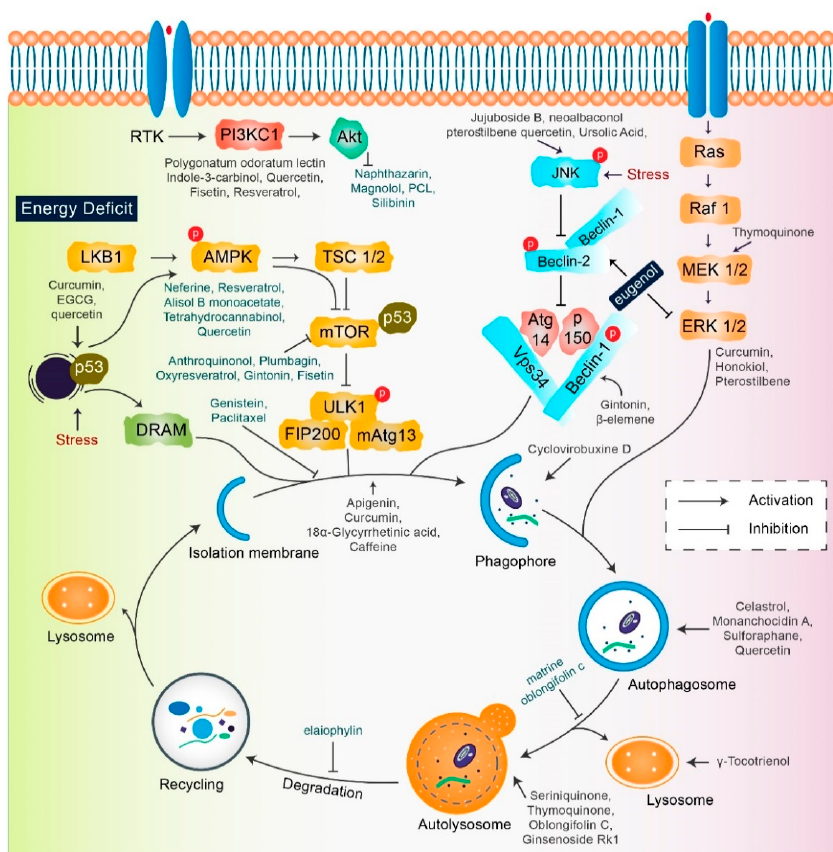
Figure 3. Key autophagy pathway and its regulators (natural compounds) for treating diverse